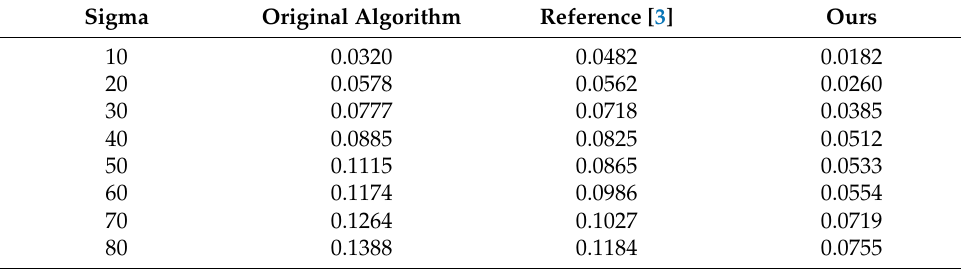
Figure 9. Detection results of the MIT image by the tested algorithms at different noise levels. ( a ) Experimental image, and Gaussian noises with standard deviations of 0, 30, 40 and 80 are added, respectively; ( b ) detection result of the traditional Sobel operator; ( c ) detection result of the algorithm proposed in Reference [3]; ( d ) detection result of the algorithm in this paper. Table 7. MSE of the three algorithms for the MIT image.